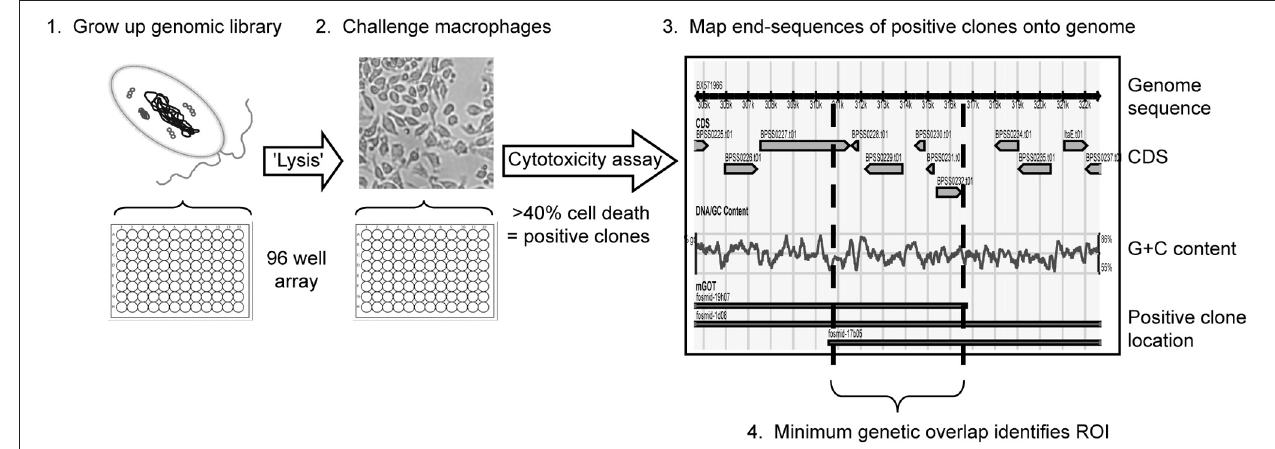
FIGURE 1 | Brief overview of the anti-macrophage screen workflow. Recombinant genomic libraries of the sequenced clinical